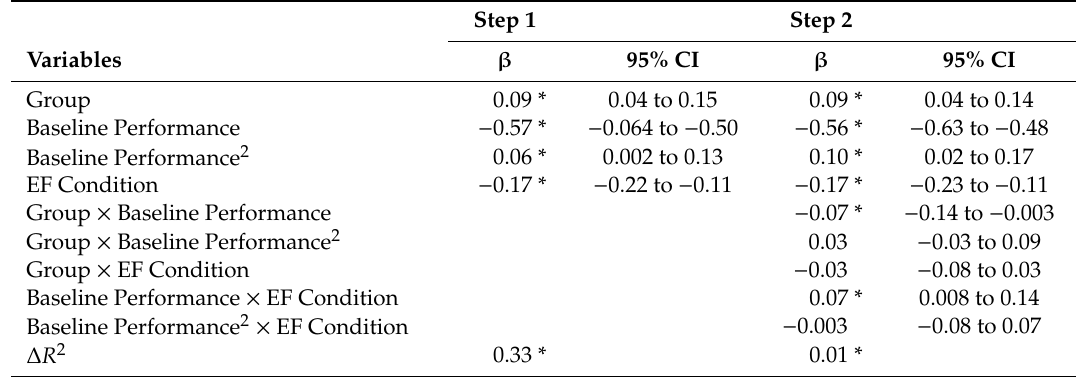
Table 2. Hierarchical multiple regression predicting the pre–post change in cognitive